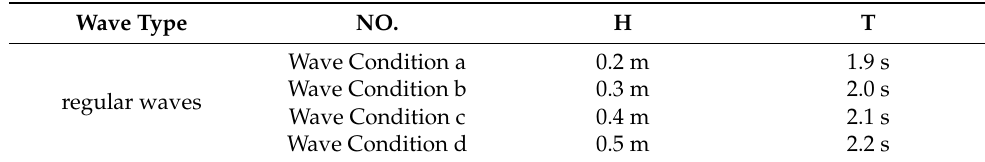
Table 1. The parameters of linear regular waves.